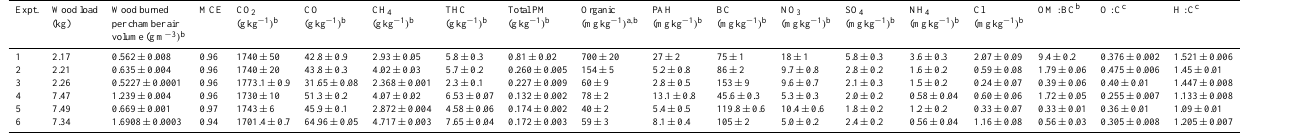
Table 1. Characterization of primary gas-phase and particle-phase emissions measured from the smog chamber. Expt. Woodload